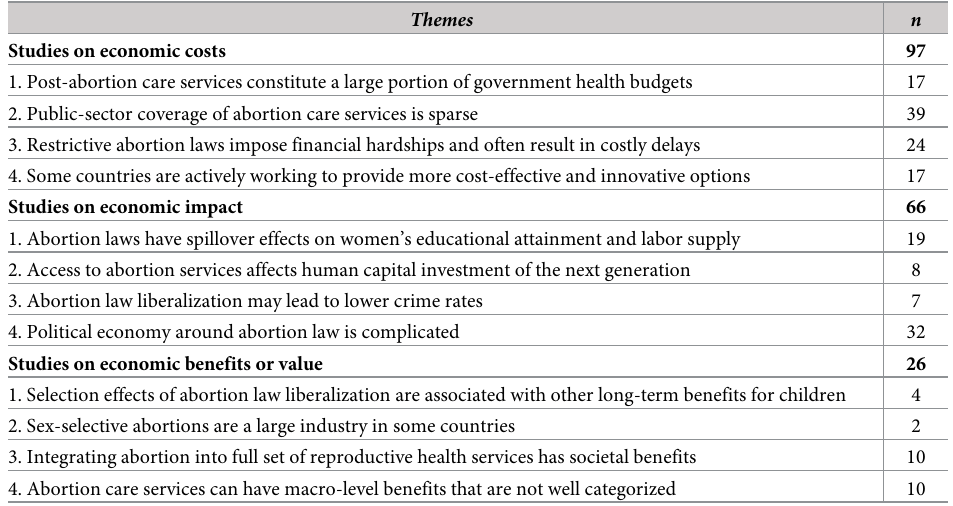
Table 5. Macroeconomic content and themes of included studies (n =